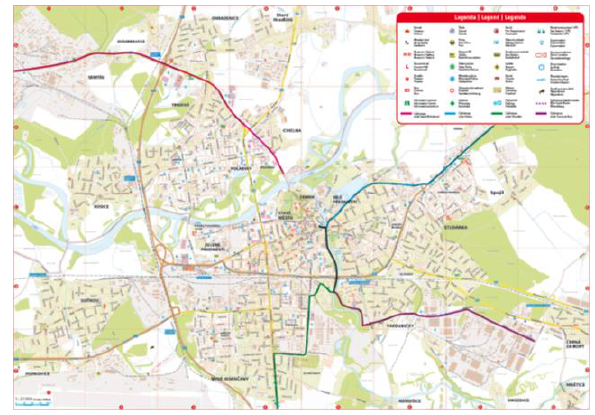
Figure 4. Map of Pardubice city (eye-tracking experiment). Although the map of Pardubice city (Fig. 4) was released as the worst during the user testing, according to user preferences this map should be good – there are used the preferred symbols, colours and map